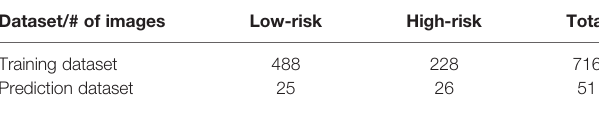
TABLE 2 | Summary of training and prediction dataset